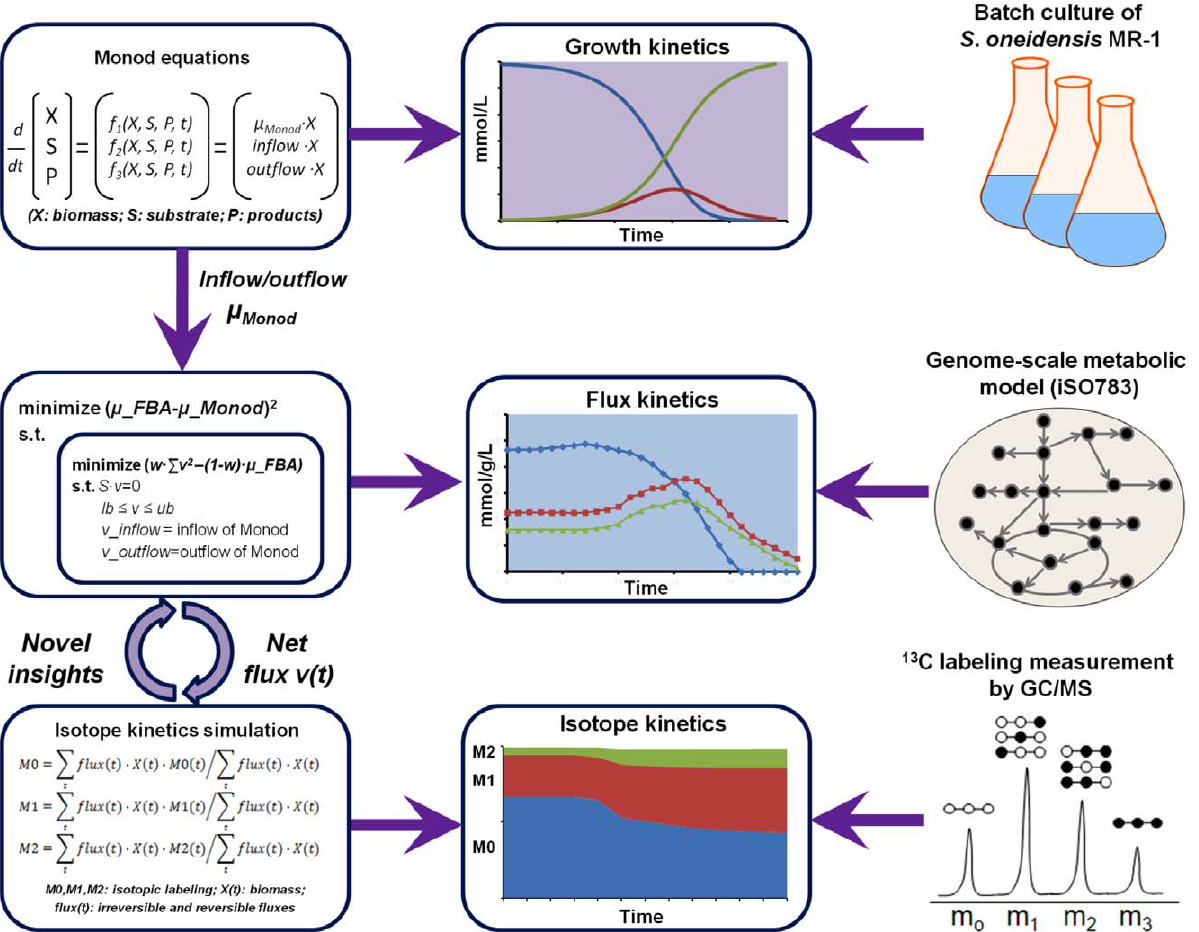
Figure 1. Flowchart of dFBA to decipher the dynamic metabolism of S.oneidensis MR-1.